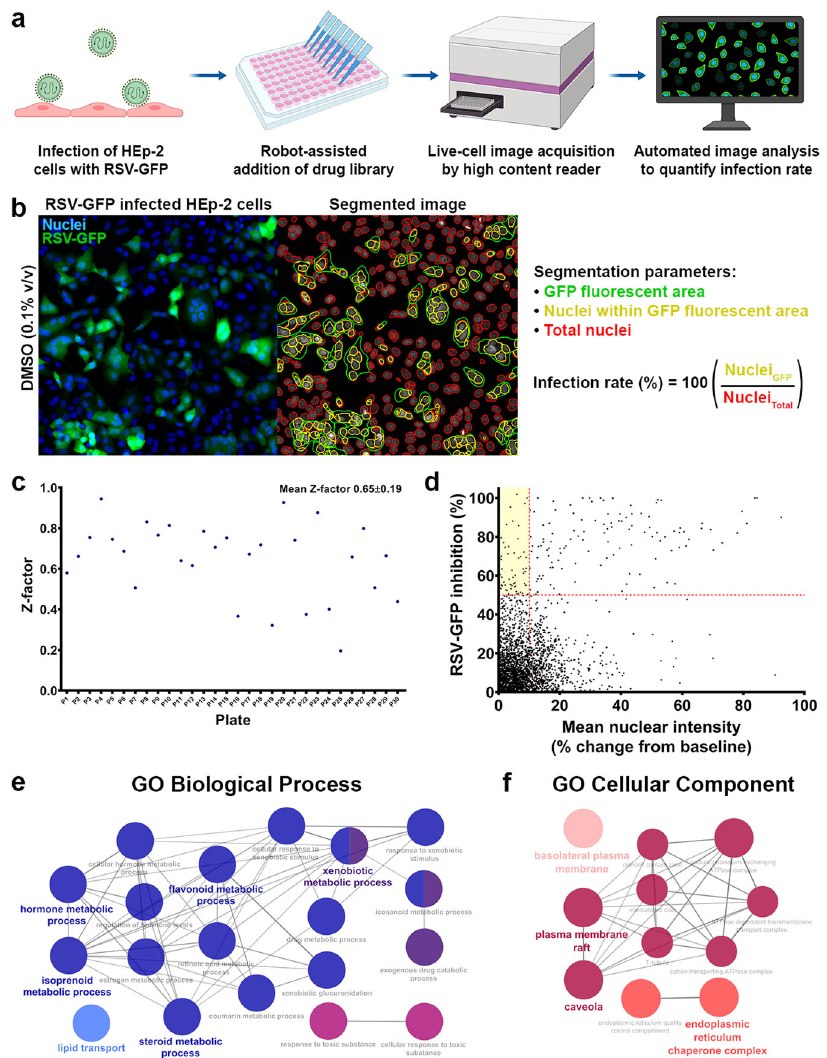
Fig. 1 High-throughput quanti fi cation of RSV infection rates by automated imaging and analysis identi fi es RSV inhibitors and host pathways targeted by the virus. a Methodology of screening for RSV inhibitors. HEp-2 cells are infected with recombinant RSV expressing green fl uorescent protein (RSV- GFP) and treated 2 h post-viral exposure with test compounds. Live cell image acquisition is performed 48 h p.i. on the Cellomics ArrayScan VTI HCS Reader and automated image analysis is performed in CellPro fi ler. b Image segmentation is used to quantify infection rate from the ratio of nuclei within GFP- fl uorescent area to total nuclei. This quanti fi cation approach accounts for in vitro syncytium formation induced by RSV, whereby a single infected cell may arise from the fusion of multiple cells. c Per-plate calculation of Z -factors to assess assay robustness. A mean Z -factor 0.65 ± 0.19 was determined for all tested plates. d Inclusion criteria of >50.0% RSV inhibition and <10.0% change in mean nuclear intensity were used to identify 60 hits from 2400 screened compounds (as indicated by the highlighted quadrant). e , f ClueGO network analysis of biological processes and cellular components enriched among the molecular targets of RSV inhibitors identi fi ed from drug screening. Steroid, isoprenoid, and other lipid metabolic processes are highly represented among screening hits. Additionally, the endoplasmic reticulum, plasma membrane, and caveolae were found to be notable sites of action in the cell during infection. Only pathways with a signi fi cance of P < 1E − 10 are